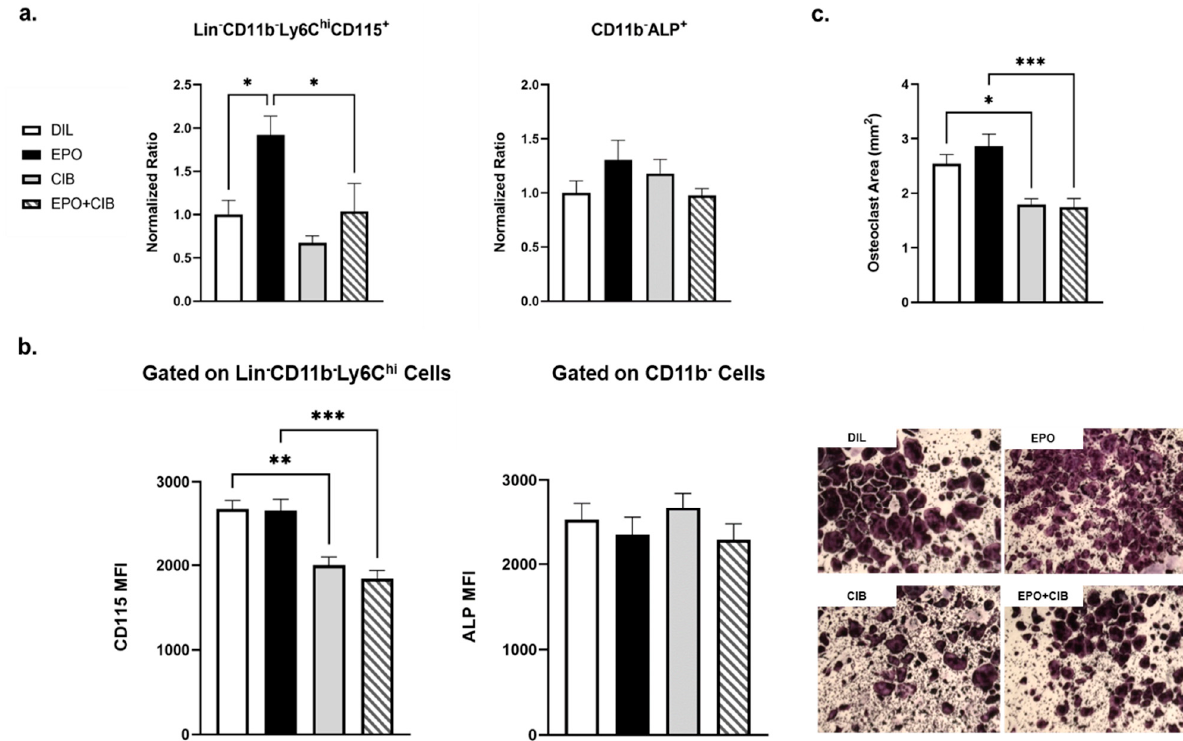
Figure 7. Reduced osteoclast progenitor numbers in combined EPO + Cibinetide (CIB) treatment. ( a ) Flow cytometry analysis of osteoclast progenitors-containing population Lin − (CD3 ε − , B220 − , Ly6G − , and TER119 − )CD11b − Ly6C hi CD115 + cells, and osteoblast precursors CD11b − ALP + . The data are mean ± SEM of values that are normalized to the diluent group. ( b ) Surface expression (mean fluorescence intensity (MFI)) of CD115 and ALP in diluent vs. EPO, Cibinetide or EPO + Cibinetide- treated mice. ( c ) Total area of multinucleated TRAP + osteoclasts grown ex vivo with M-CSF and